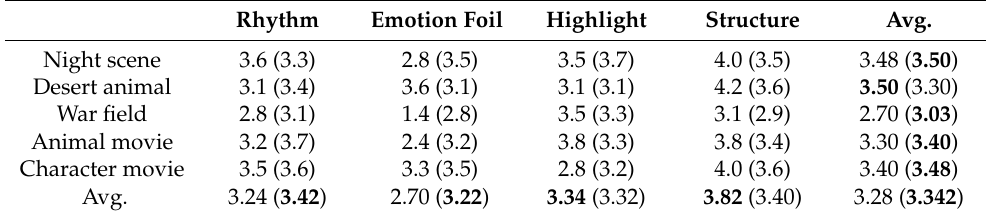
Table 1. The score of the expert group on algorithmically generated music and music made by composers on 4 indicators. (The values in the table represent the score of the music generated by the algorithm, and the values in brackets represent the score of the music made by the